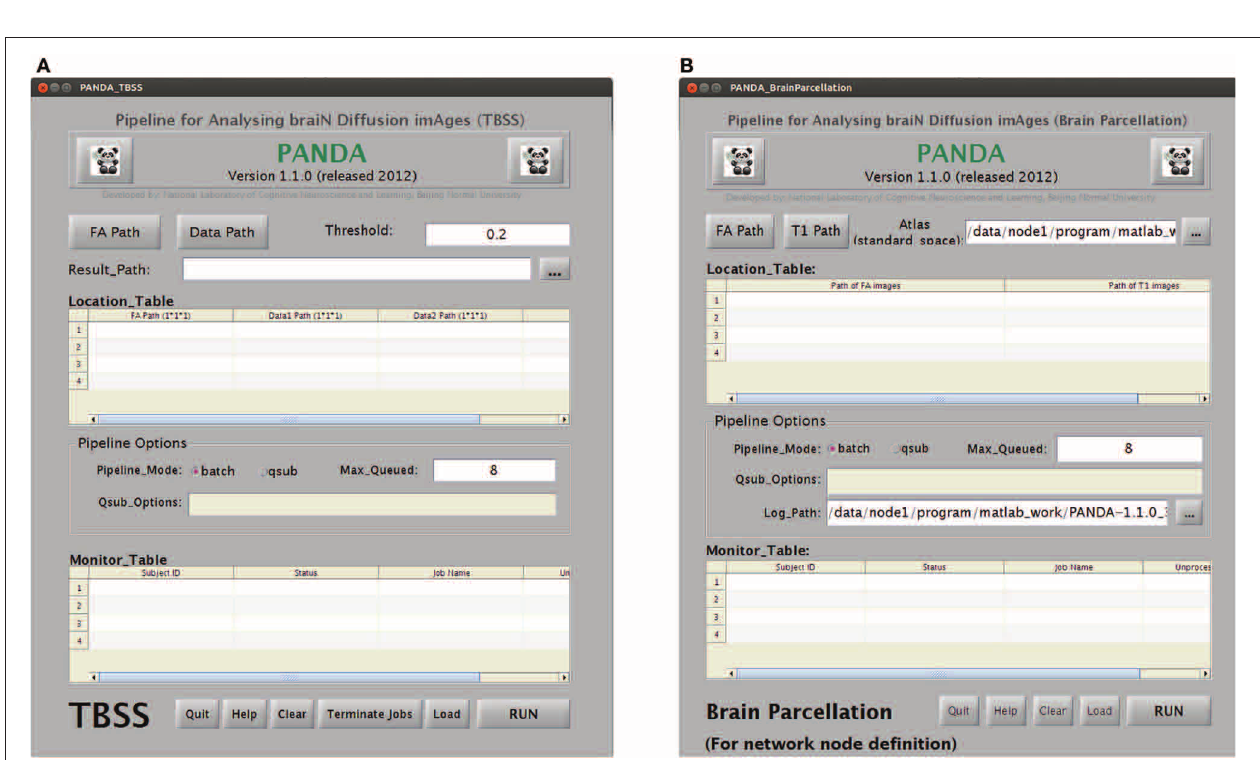
FIGURE B2 | Snapshots of the GUI for configuring the processing parameters. (A) A snapshot of the GUI for changing the preprocessing parameters and for producing diffusion metrics that are ready for statistical